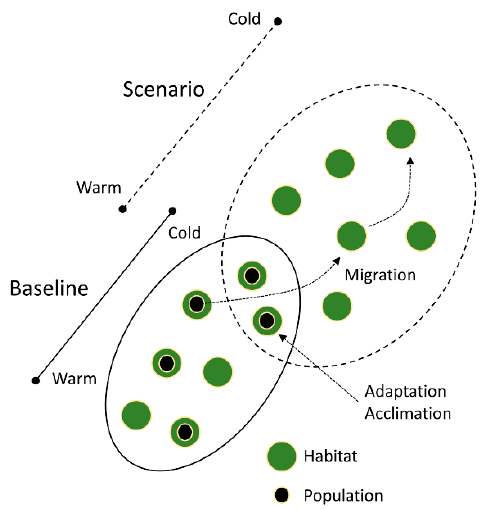
Figure 4. Bioclimatic models can be used to frame questions about species vulnerability and climate change risk; the solid-line envelope of suitable climate at the baseline may shift spatially under a climate change scenario (dashed-line envelope). Consequently: species may or may not be able to migrate among habitat patches to track this shifted suitable climate, or individual populations at the colder range edge (baseline) may transition towards the warmer range edge under climate change and may therefore need to adapt, depending on standing genetic diversity and gene flow, or acclimate through phenotypic plasticity including photobiont switching.